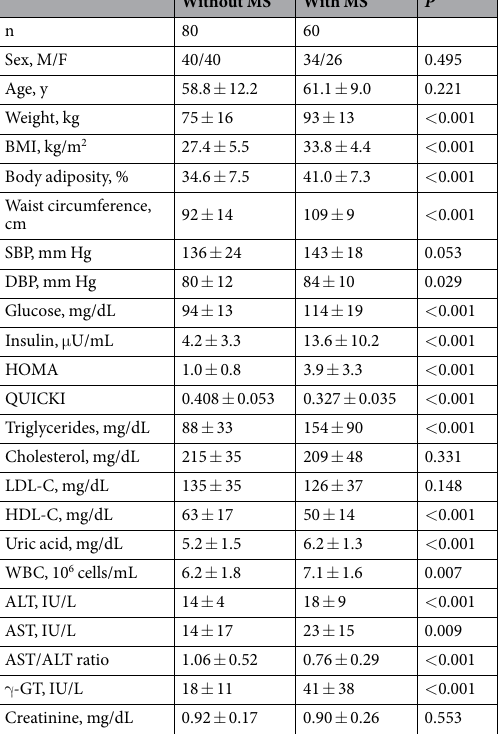
Table 1. Demographic and biochemical characteristics of the individuals at enrollment. Data presented as mean ± SD. Individuals were matched by age and sex. MS, metabolic syndrome; BMI, body mass index; SBP, systolic blood pressure; DBP, diastolic blood pressure; HOMA, homeostatic model assessment; QUICKI, quantitative insulin sensitivity check index; LDL-C, low-density lipoprotein-cholesterol; HDL-C, high- density lipoprotein-cholesterol; WBC, white blood cells; ALT, alanine aminotransferase; AST, aspartate aminotransferase; γ -GT, γ -glutamyltransferase. Differences between groups were analyzed by two-tailed unpaired Student’s t tests. Differences in gender distribution were analyzed by χ 2